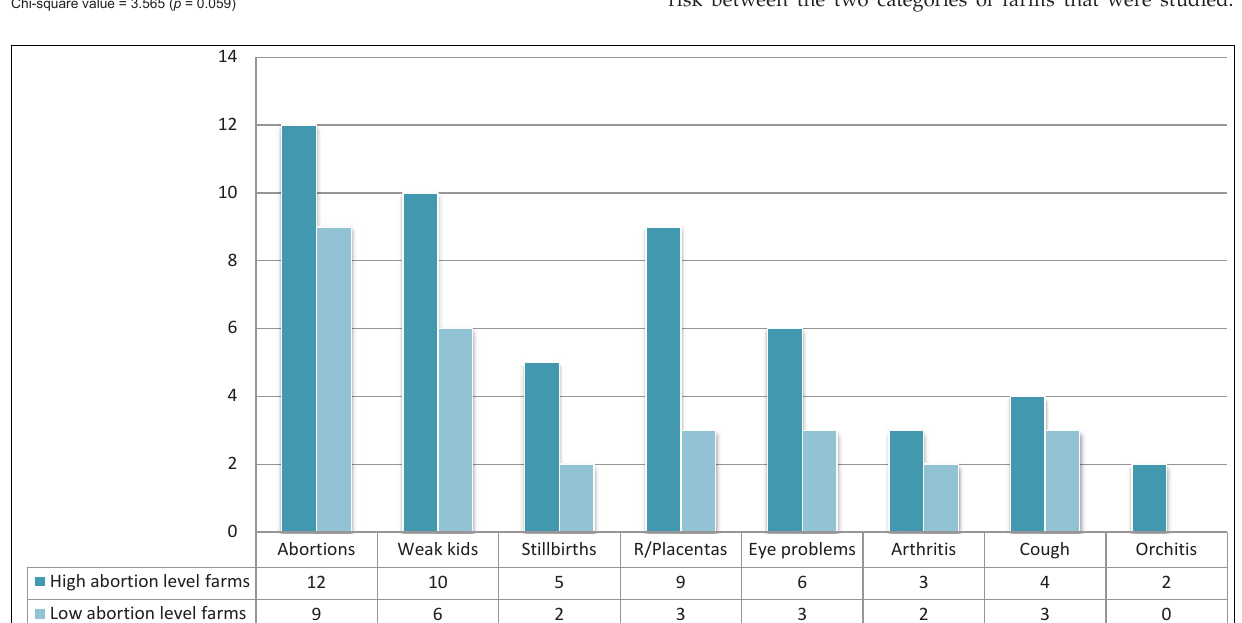
FIGURE 2 Histogram showing the scores for various clinical conditions in the two farm categories studied